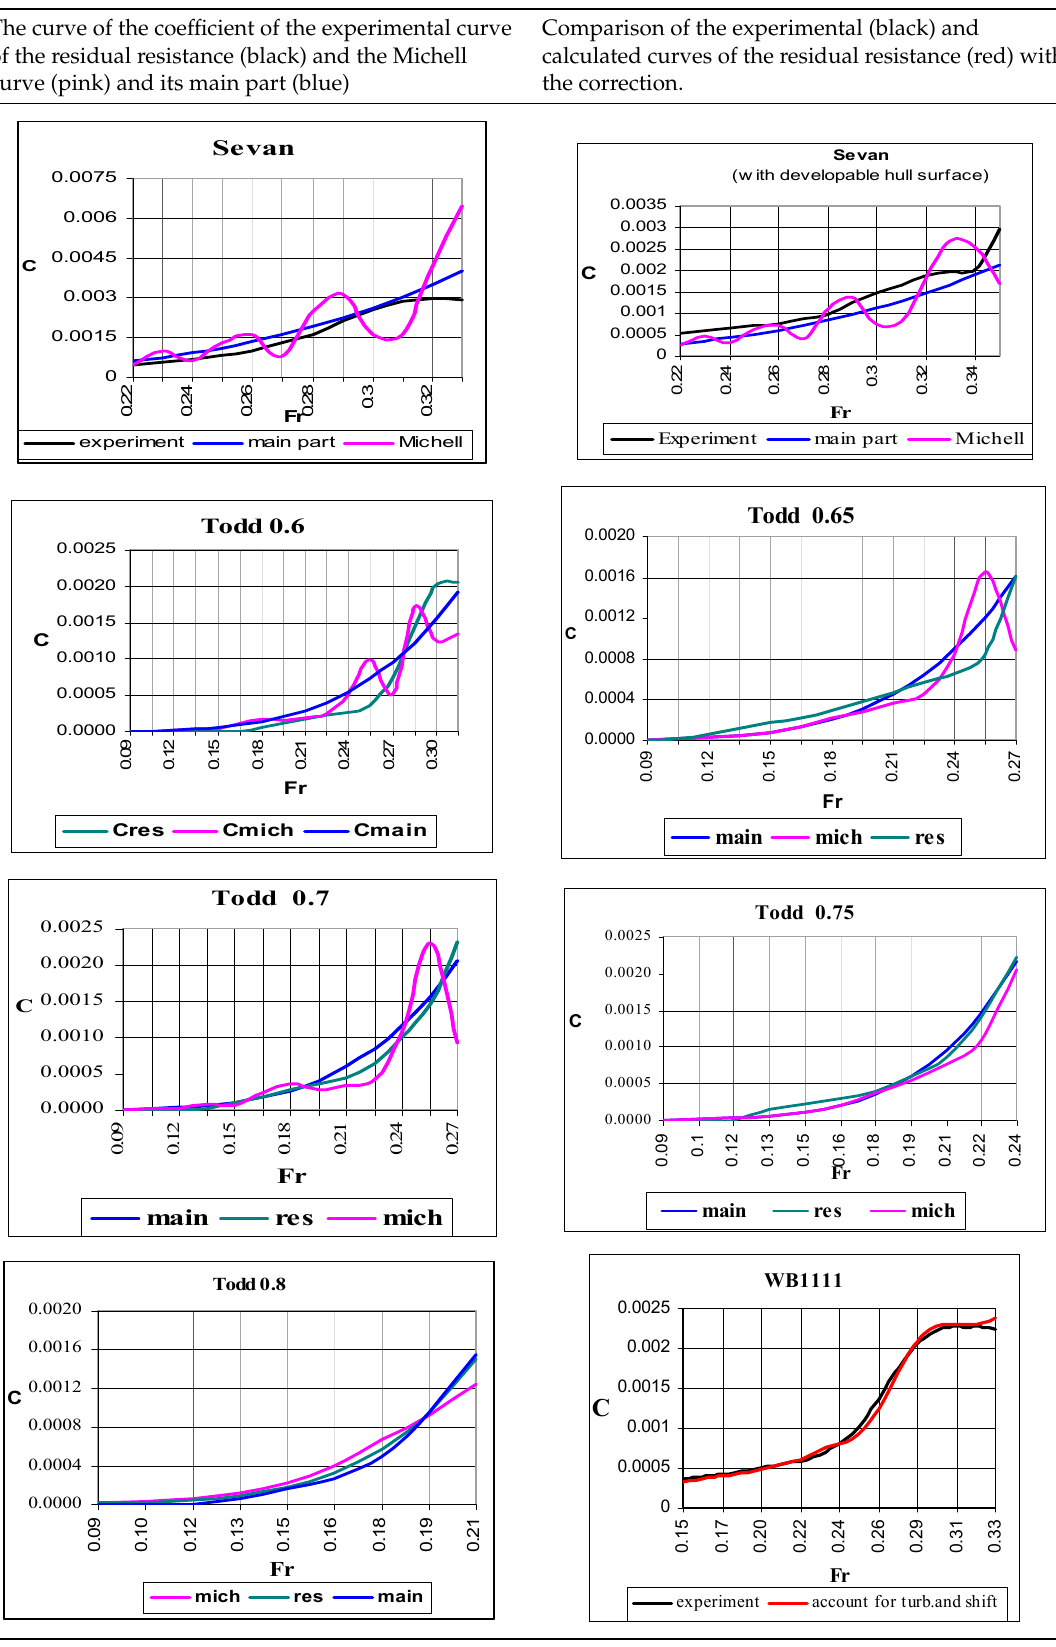
Table 7. Cont. residual resistance (black curve) of Todd models.